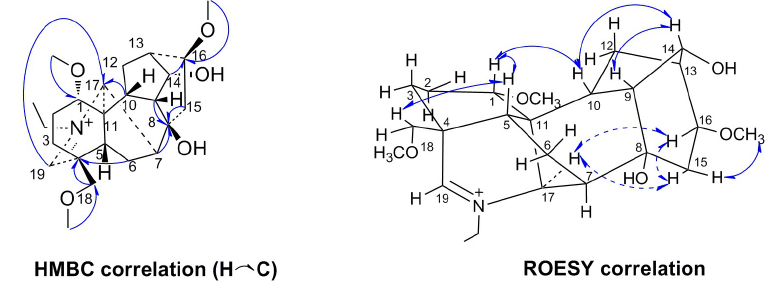
Figure 4. Key HMBC (H → C) and ROESY (H ↔ H) correlations of Compound 3 .